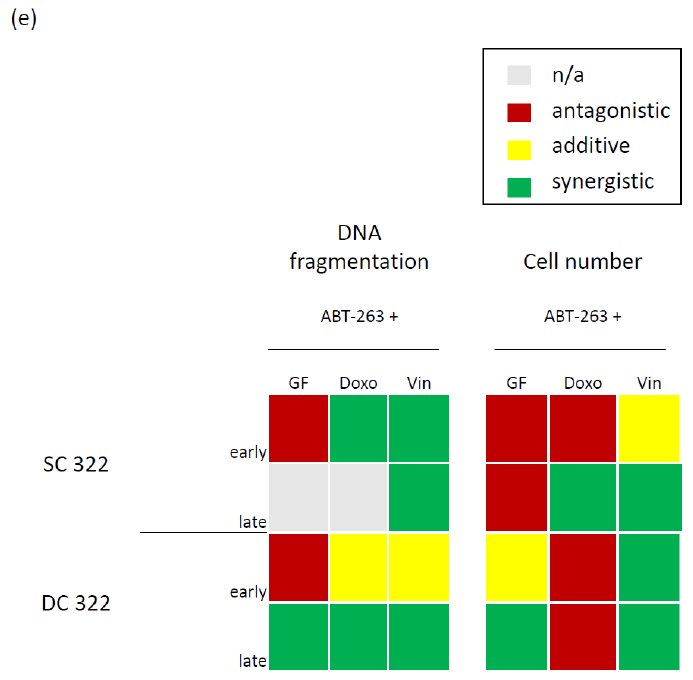
Figure 4. The Bcl-XL/Bcl-2 inhibitor ABT-263, but not the Bcl-2 inhibitor ABT-199, shows therapeutic potential in primary medulloblastoma (MB) cells. ( a ) The inhibitor of Bcl-2, ABT-199, does not show a therapeutic effect on the metabolism of primary MB cells. The stem cell-like cells (SC322, left) or their differentiated progeny (DC322, right) were cultured in the presence of ABT-199, reduced growth factor/serum concentrations, doxorubicin or two concentrations of vincristine as well as ABT-199 combined with the different stressors (concentrations as indicated). Metabolic activity was assessed after 24 and 96 h and normalized to the solvent-treated control population. ( b ) The inhibitor of Bcl-XL/Bcl-2, ABT-263, shows a therapeutic effect on the metabolism of primary MB cells. The experimental setup was similar to 4A. Metabolic activity was assessed after 24 and 96 h and normalized to the solvent-treated control population. ( c ) ABT-263 shows a therapeutic effect on cell death induction of primary MB cells. The stem cell-like cells (SC322, left) or their differentiated progeny (DC322, right) were cultured in the presence of 1 µM ABT-263, reduced growth factor/serum concentrations (as indicated), 5 nM doxorubicin or 0.5 nM vincristine as well as ABT-263 combined with the different stressors. Percentage of specific DNA fragmentation was determined 24 and 96 h after stimulation by flow cytometric analysis of PI-stained nuclei. ( d ) ABT-263 shows a therapeutic effect on living cell number of primary MB cells. The experimental setup was similar to 4C. The total living cell number was assessed 24 and 96 h after stimulation by CASY1 DT measurement and normalized to solvent-treated control population for each time point. ( e ) Combining ABT-263 and various stressors frequently elicits a synergistic effect in primary MB cells. The effects of combining ABT-263 with different stressors on apoptosis (left) and living cell number (right), as shown in ( c ) and ( d ), respectively (early, 24 h; late, 96 h), were analysed for synergism. Using Bliss analysis, synergistic (green), additive (yellow) or antagonistic (red) effects were determined, while grey indicates that Bliss analysis was mathematically not possible to perform. In ( a – d ) columns represent mean and SD of three independent experiments performed in triplicates.